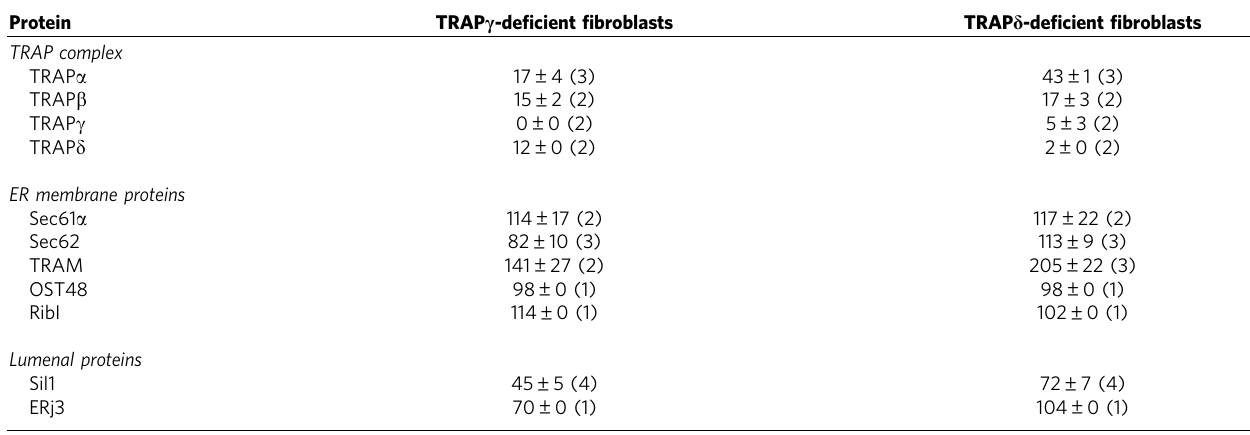
Table 1 | Relative protein content of TRAP subunits and select ER-resident proteins in patient fibroblasts. Protein TRAP c -deficient fibroblasts TRAP d -deficient fibroblasts TRAP complex TRAP